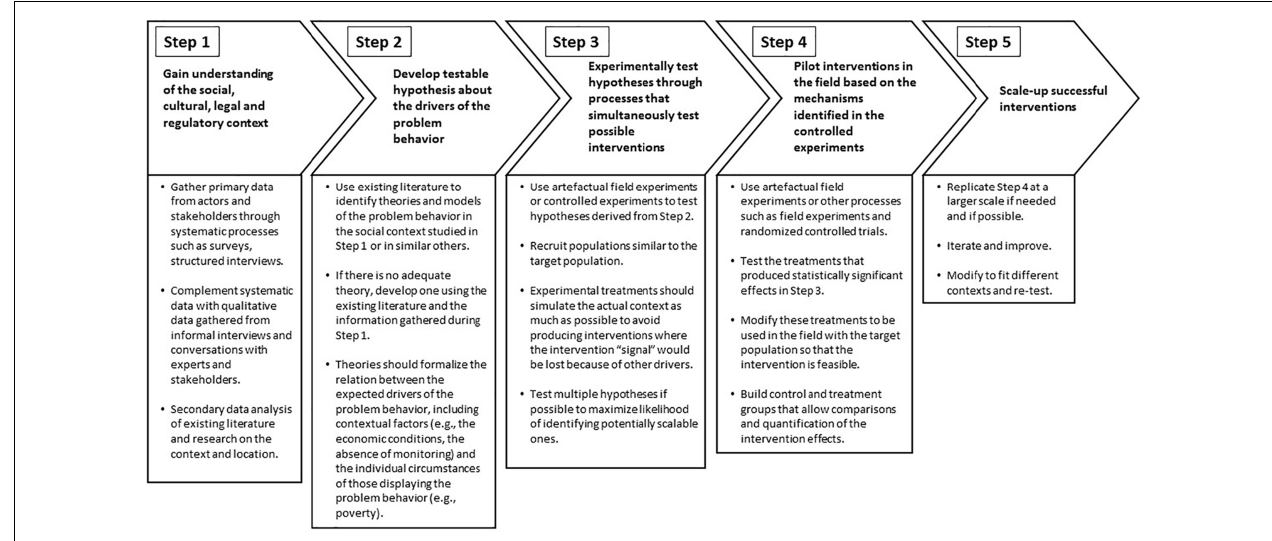
FIGURE 1 | Flow diagram of five step process for designing and implementing empirically supported behavioral interventions to reduce illegal